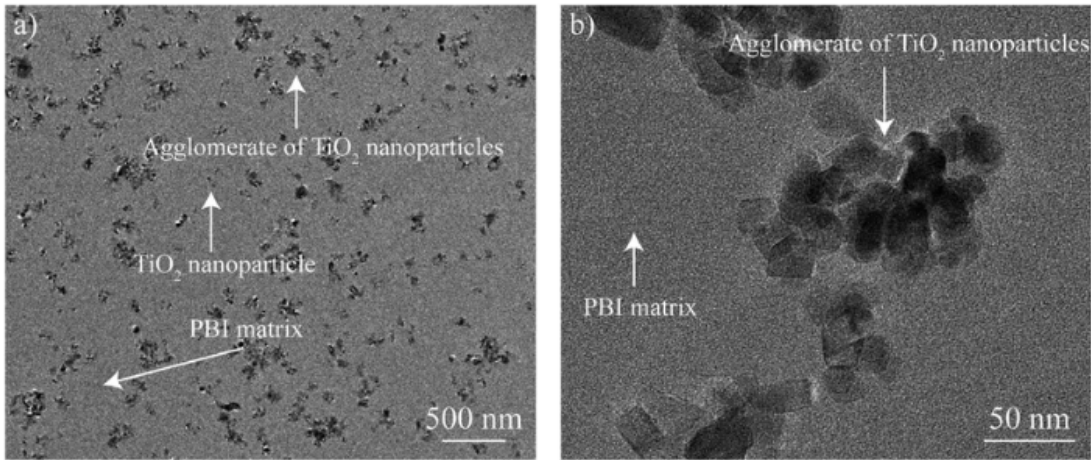
Figure 7. TEM images of TiO 2 nanoparticles on polybenzimidazole (PBI) membrane with the addition of TiO 2 nanoparticles: ( a ) At a magnification of 500 nm, ( b ) at a magnification of 50 nm [31].